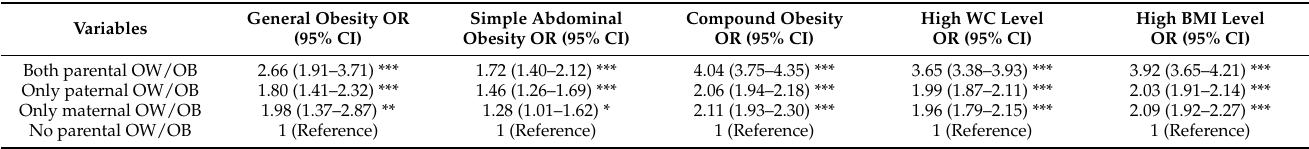
Table 2. Association of OW/OB between parents and